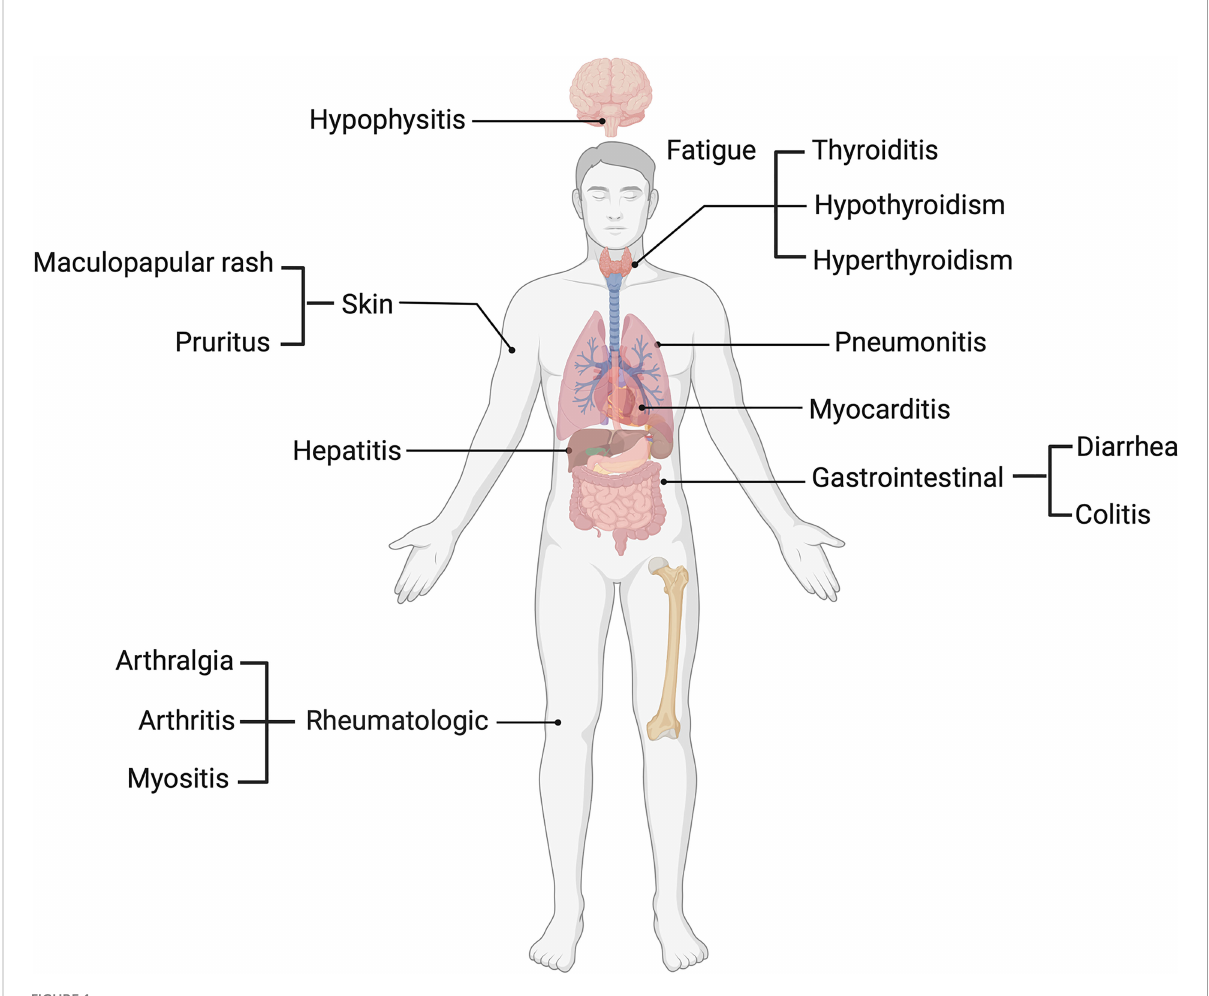
FIGURE 1 Common immune related adverse events in melanoma